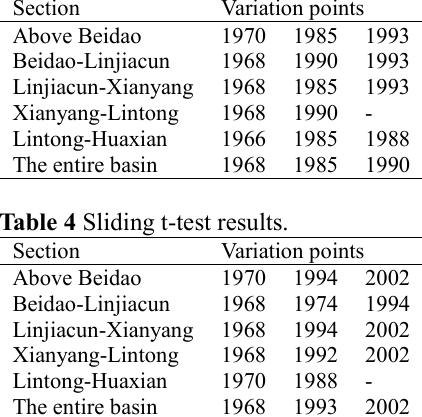
Table 1 Mann-Kendall test results.